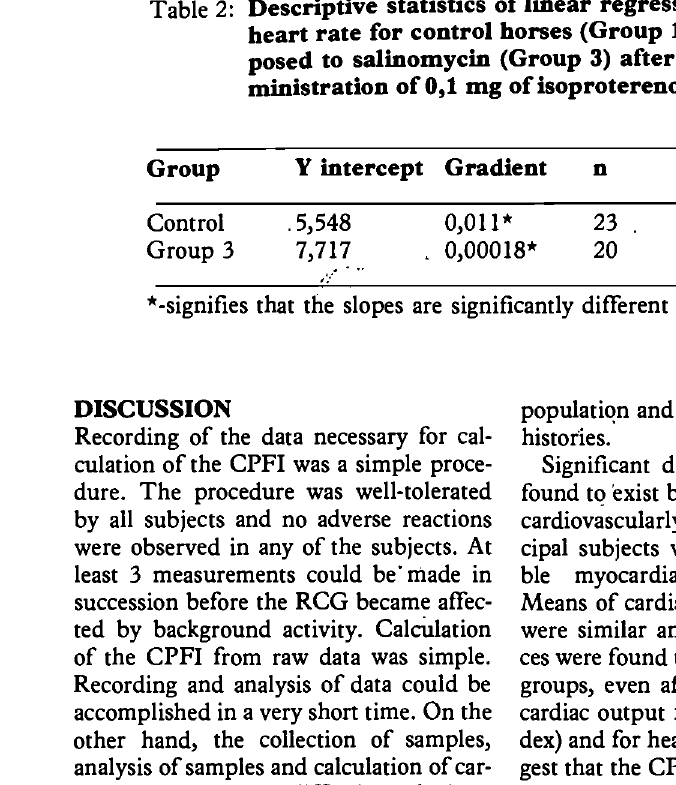
Table 2: Descriptive statistics of linear regressions of CPFI on heart rate for control horses (Group 1) and horses ex posed to salinomycin (Group 3) after intravenous ad ministration of 0,1 mg of isoproterenol Group Y intercept Gradient n r P Control .5,548 0,011 * 23 0,58 <0,05 Group 3 7,717 0,00018* 20 0,02 >0,05 ,:/' ...